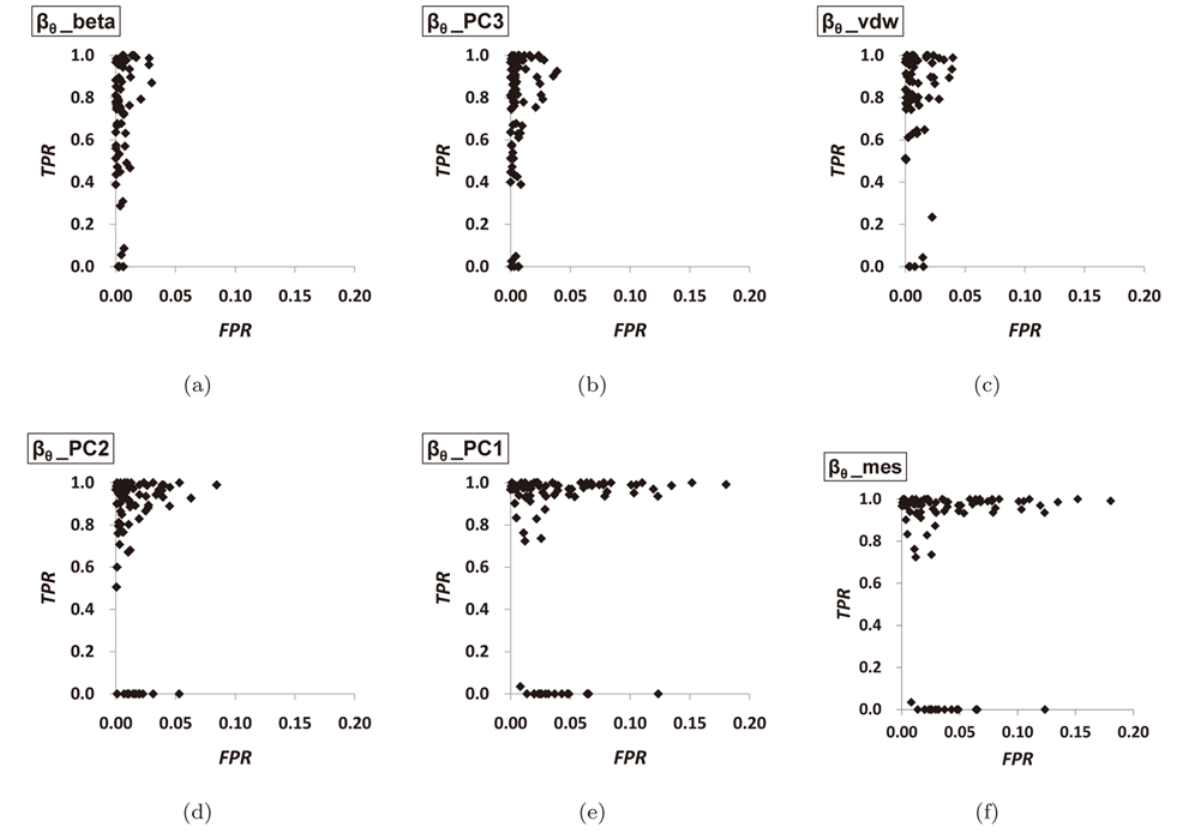
Fig 11. The ROC-graph of the L-descriptors. (a) the beta-shape volume, (b) the PC3, (c) the van der Waals volume, (d) the PC2, (e) the PC1, and (f) the minimum enclosing